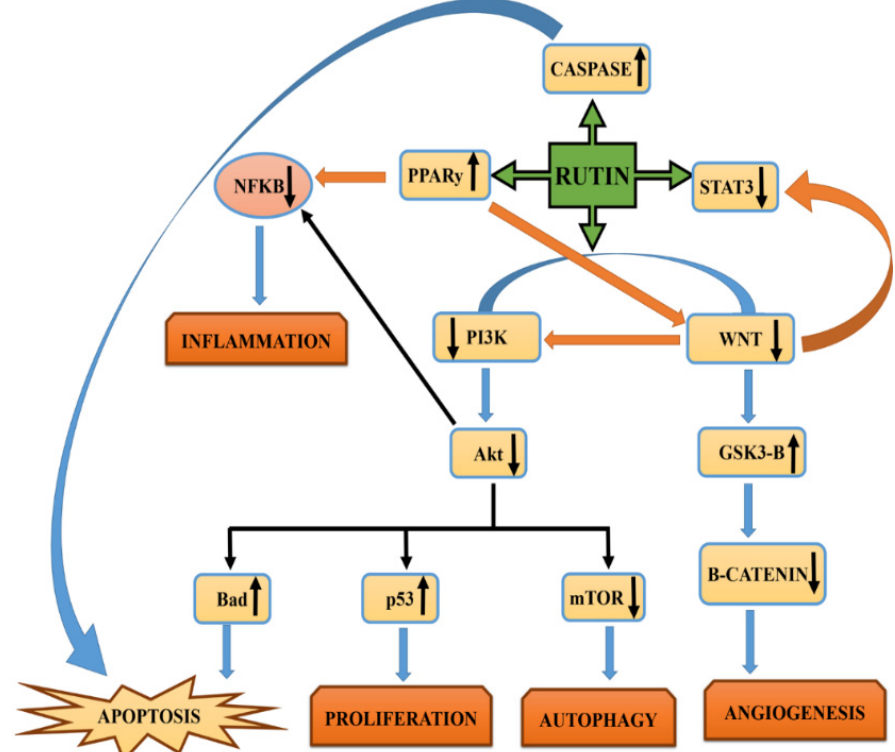
Figure 2. Mechanism associated with the anticancer potential of rutin via the targeting of numerous molecular signaling pathways.